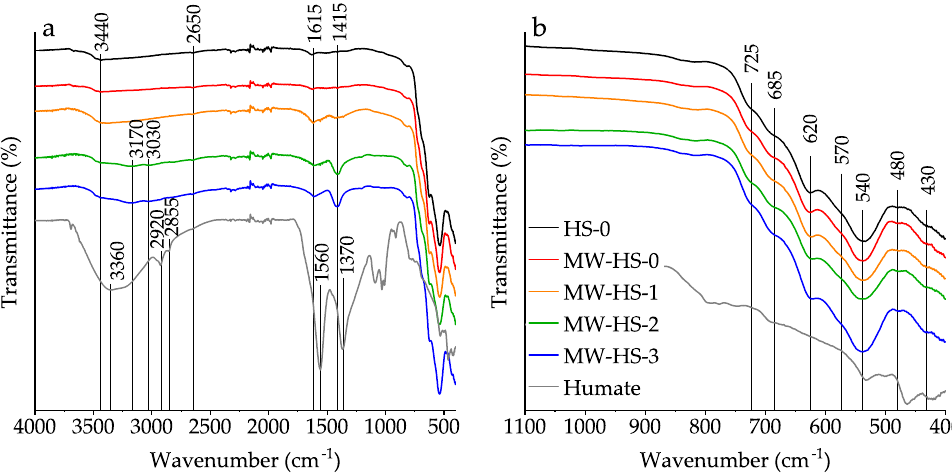
Figure 3. FTIR spectra ( a ) in the whole scanning range and ( b ) in the middle infrared region of the obtained samples and potassium humate